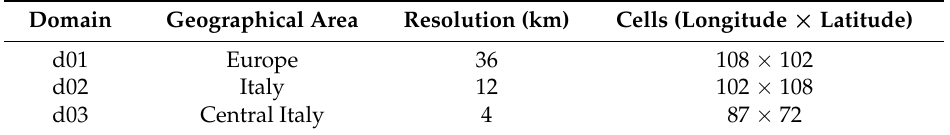
Figure 5. Weather Research and Forecasting (WRF) model domains: ( a ) geographical areas; and ( b ) land-use categories from the moderate resolution imaging spectroradiometer (MODIS) dataset in the innermost domain. Table 4. Simulation domains for numerical experiments with the Weather Research and Forecasting (WRF) model.